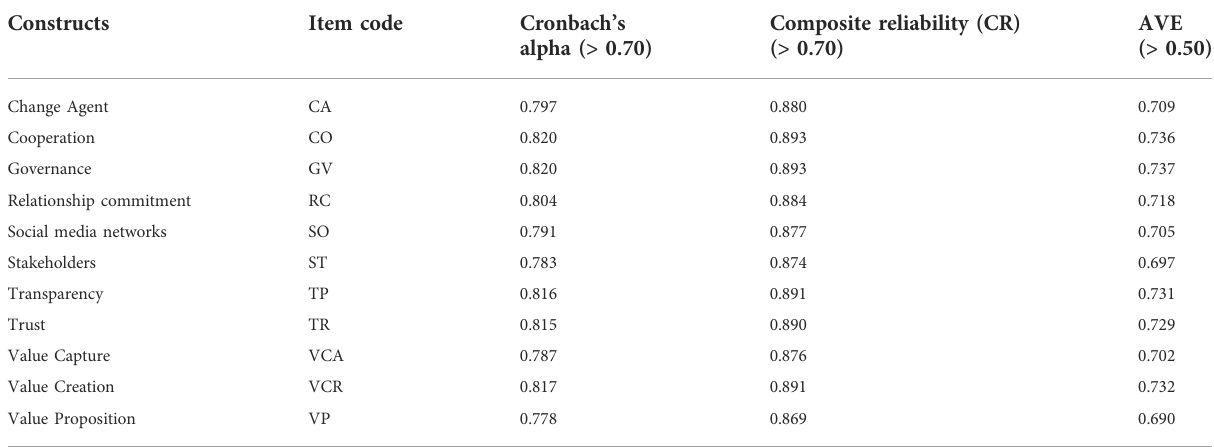
TABLE 4 Build reliability and